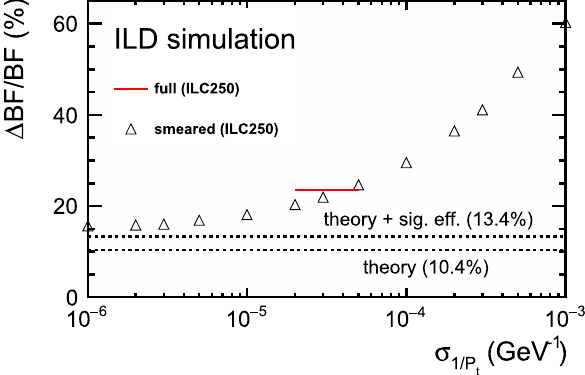
Fig. 9 Expected precision on BF ( H → μ + μ − ) as a function of trans- verse momentum resolution σ 1 / P (triangles), together with full simu- t lation results discussed in Sect. 3.7 (red line) and the theoretical limits √ s = 250 defined in Sect. 3.7 (dashed lines) for 2 ab − 1 collected at GeV. The red line indicates the typical transverse momentum resolution √ s = 250 GeV range at